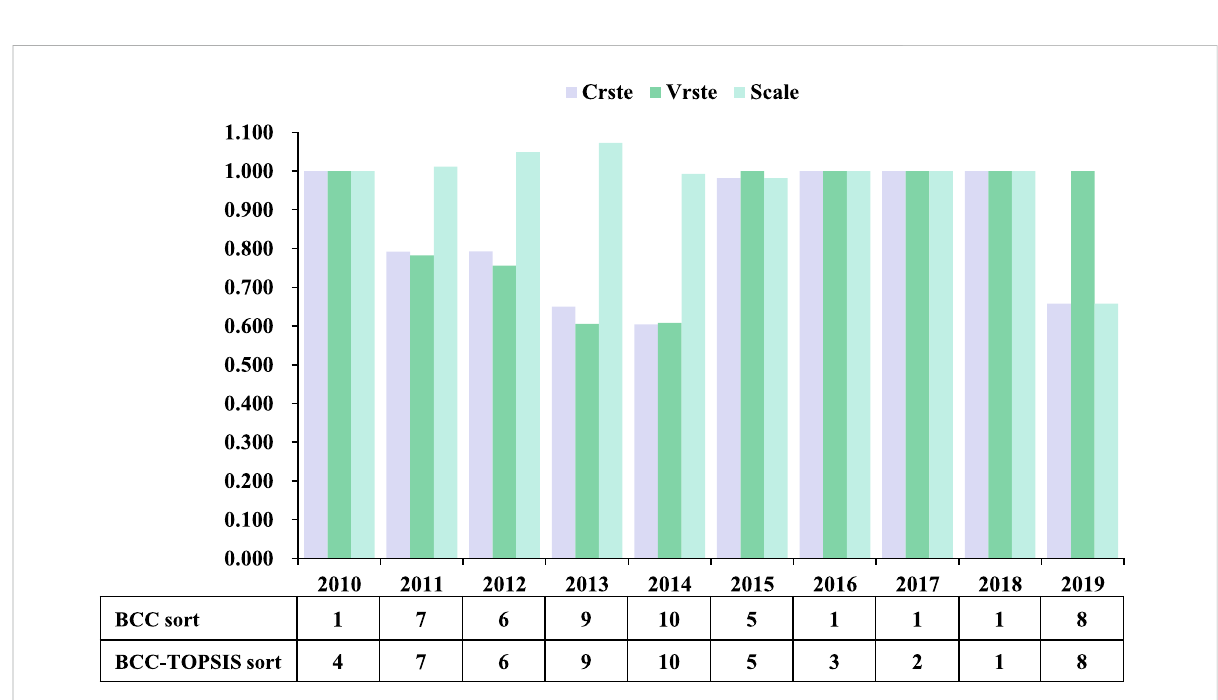
FIGURE 7 Evaluation results of the ef fi ciency of E. ON ’ s investment and merger in the fi eld of energy